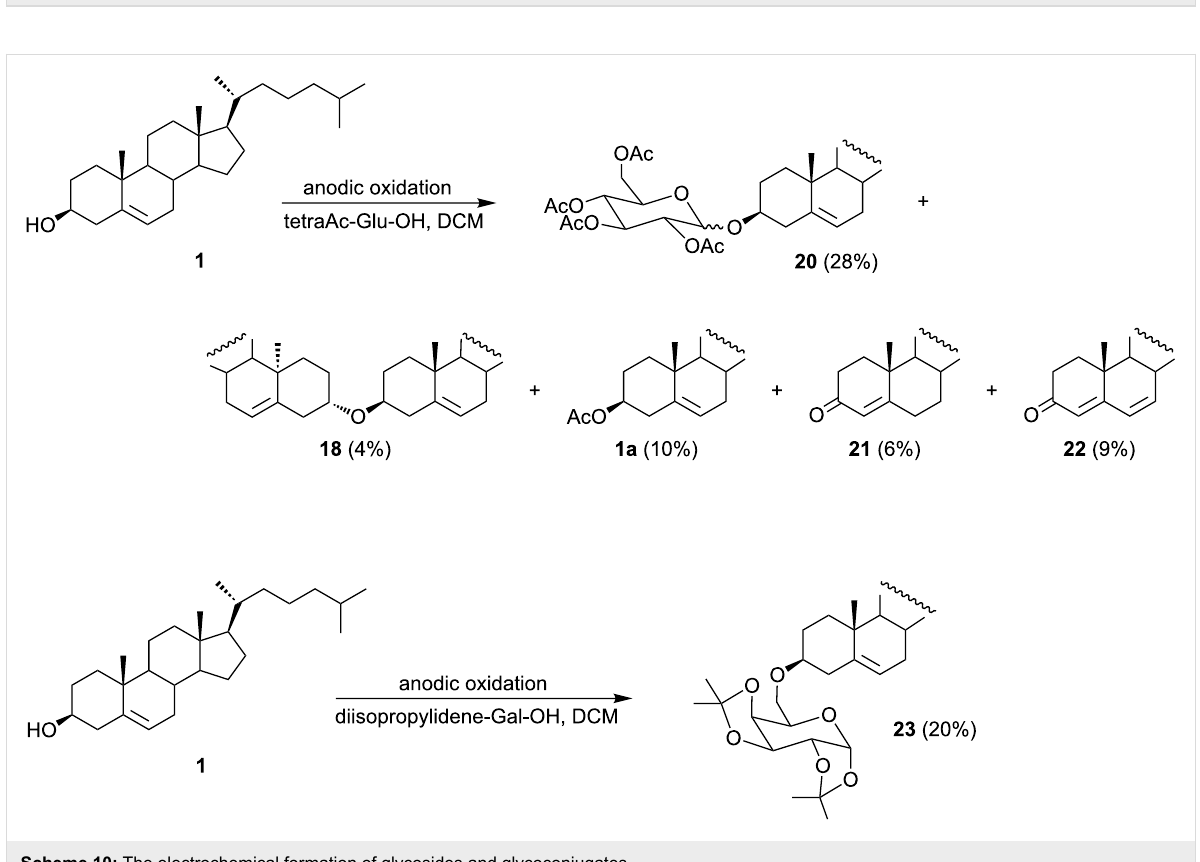
cholest-4-en-3-one ( 21 , 6%), and cholesta-4,6-dien-3-one ( 22 ,